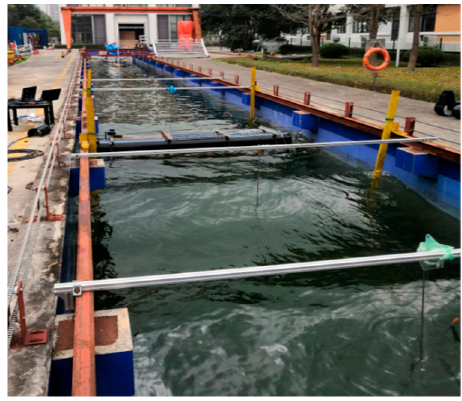
Figure 8. Testing site.